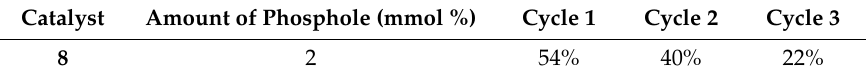
Table 4. Catalytic Mitsunobu reaction: yields of benzoate 16 over the different cycles. Catalyst